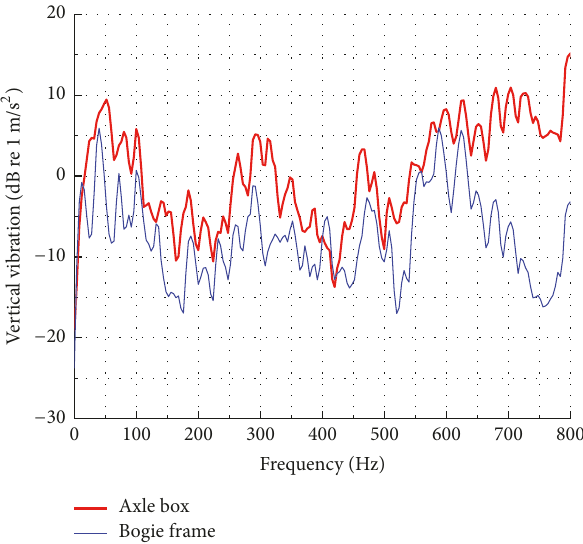
Figure 3: Vibrations of bogie frame and axle box.